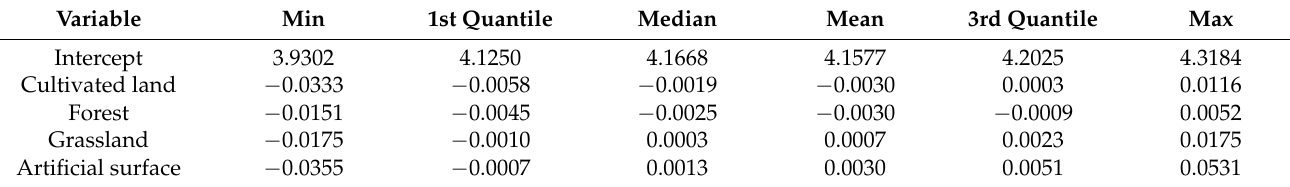
Table 1. Summary of the MGWR coefficient